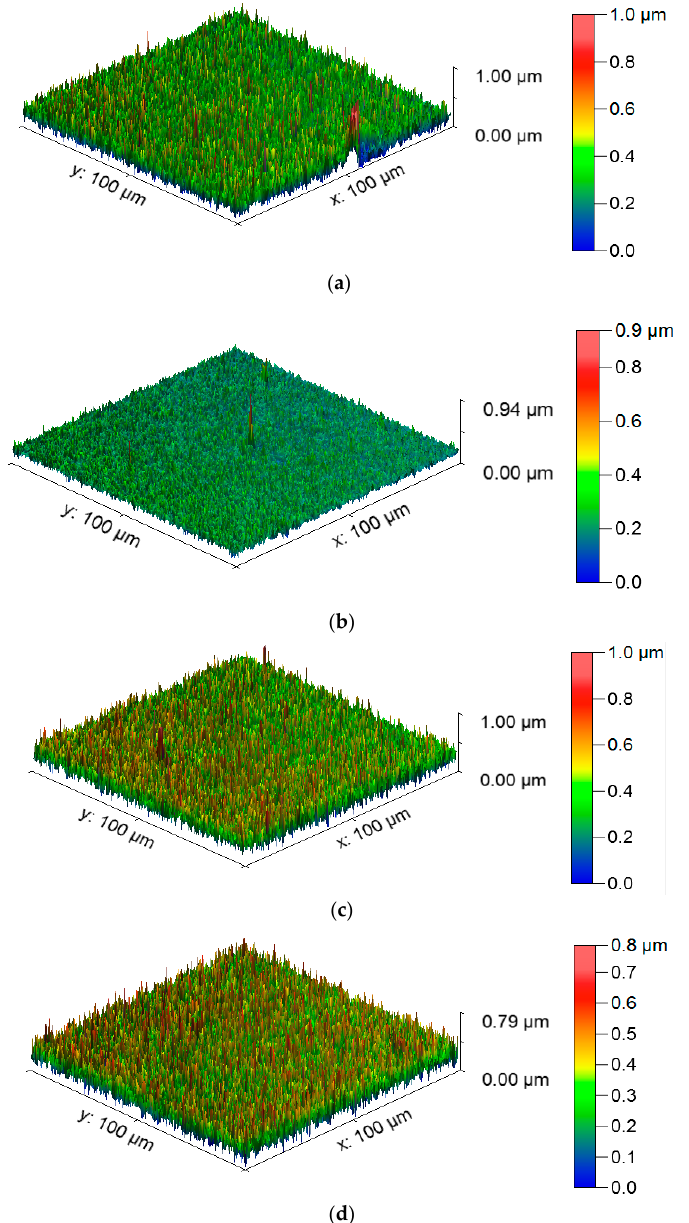
Figure 11. 3D laser profilometry of the corrosion test: ( a ) Expt. 1, ( b ) Expt. 2, ( c ) Expt. 3, and ( d ) Expt. 4.